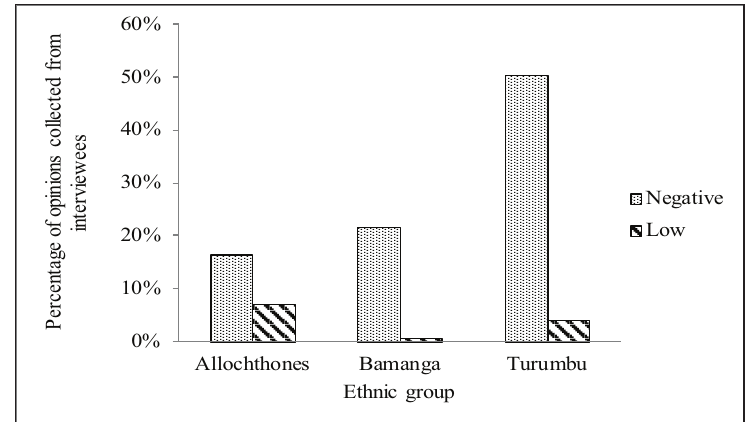
Figure 5. Opinion on the impact of development projects in the